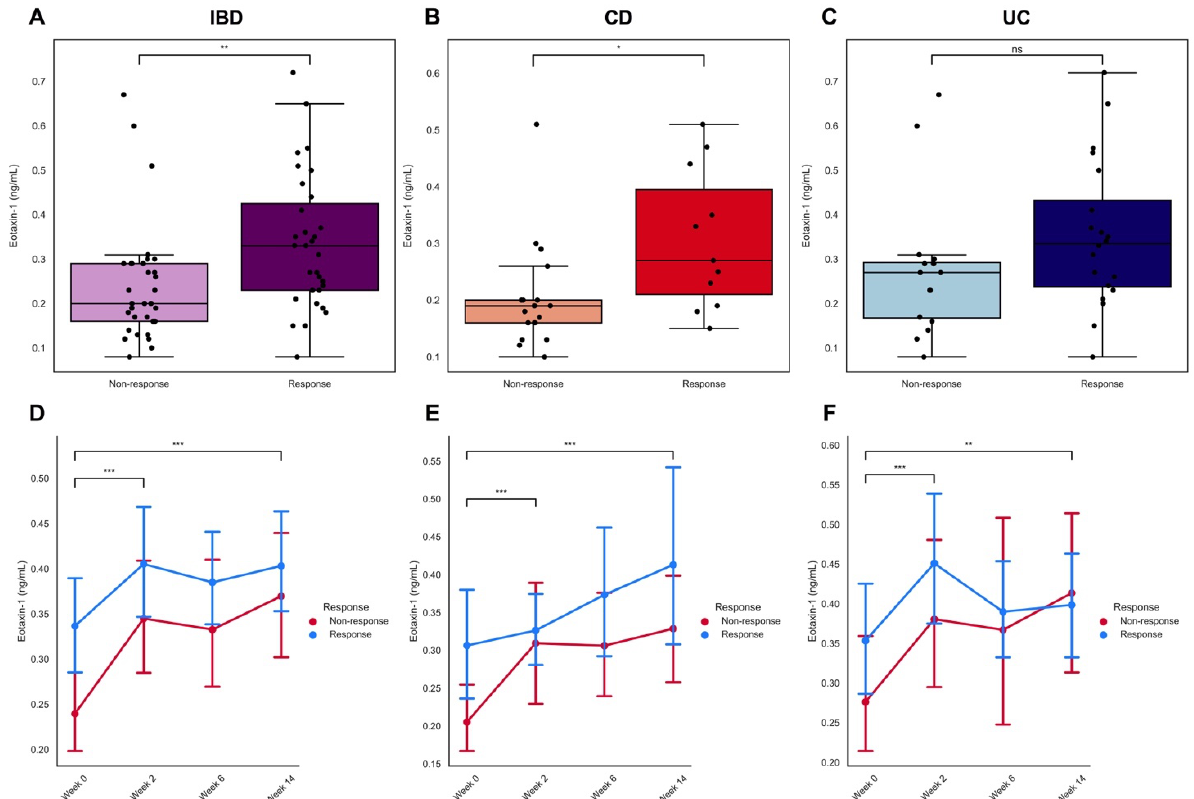
Figure 2. ( A – F ). Serum eotaxin-1 levels (ng/mL) among clinical responders and primary non-responders to vedolizumab induction therapy in the discovery cohort. ( A ) Baseline serum eotaxin-1 levels (ng/mL) were significantly higher in patients with IBD eventually responding to vedolizumab induction therapy versus those who did not. ( B , C ) Baseline serum eotaxin-1 levels (ng/mL) were significantly elevated in patients with Crohn’s disease (CD) who eventually clinically responded to vedolizumab, whereas in patients with UC, no significant difference was observed when comparing responders to non-responders. ( D – F ) Serum eotaxin-1 levels (ng/mL) significantly increased in patients during the course of vedolizumab induction therapy, in both responders and non-responders. * p < 0.05; ** p < 0.01; *** p < 0.001.